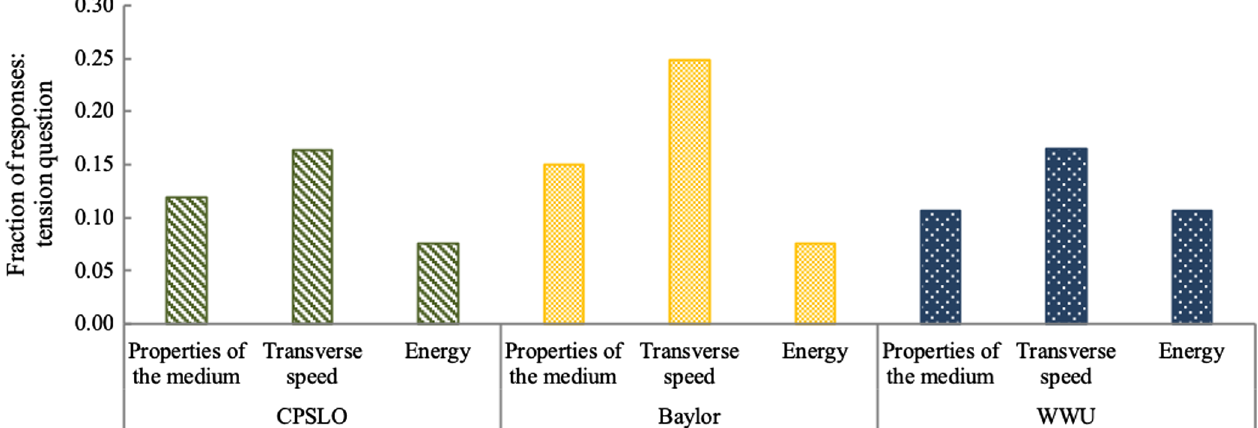
FIG. 4. Fraction of responses using three common resources for the tension question.